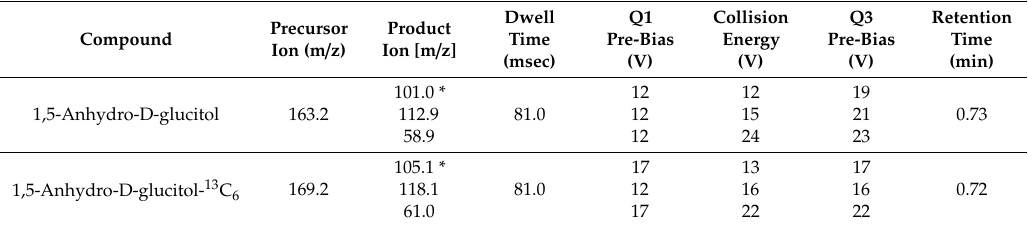
Table 2. Multiple reaction monitoring conditions used in the UHPLC / ESI-MS / MS analyses of 1,5-anhydroglucitol and internal standard.